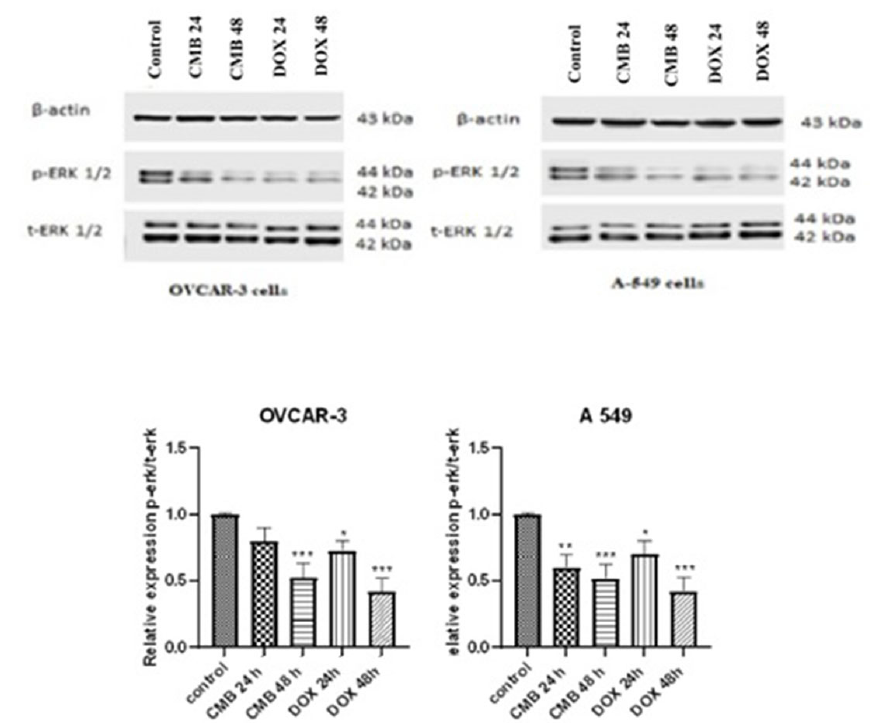
Figure 5. Western blots of ERK1/2 protein expression in OVCAR-3 and A-549 cells incubated with CMB and doxorubicin at IC 50 values for 24 h or 48 h. Means and SE were calculated from three independent experiments. Statistically significant results relative to untreated control were presented as: * p < 0.05; ** p < 0.01; *** p < 0.001.